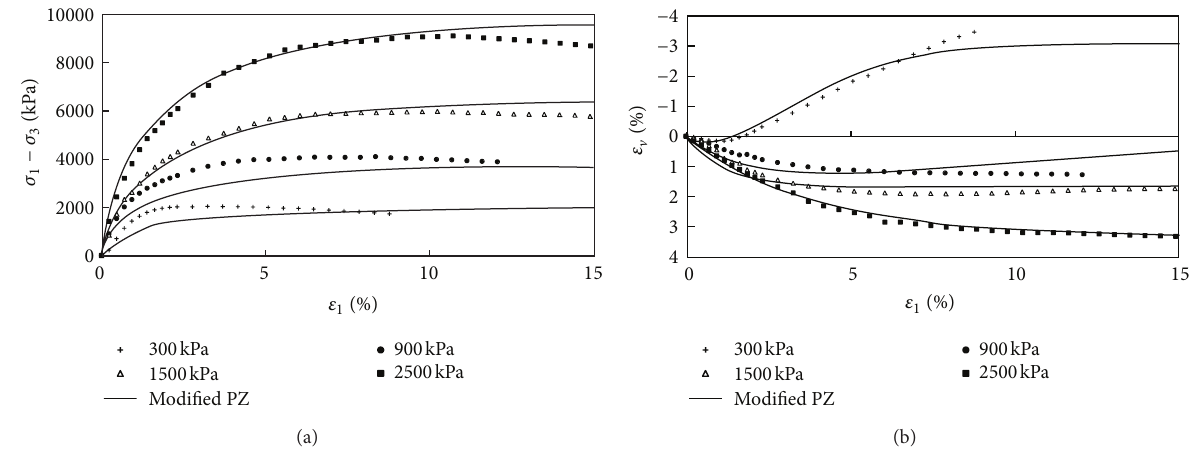
Figure 5: Comparison between fittings of the modified PZ-III model and experimental triaxial tests results for rockfill material I.